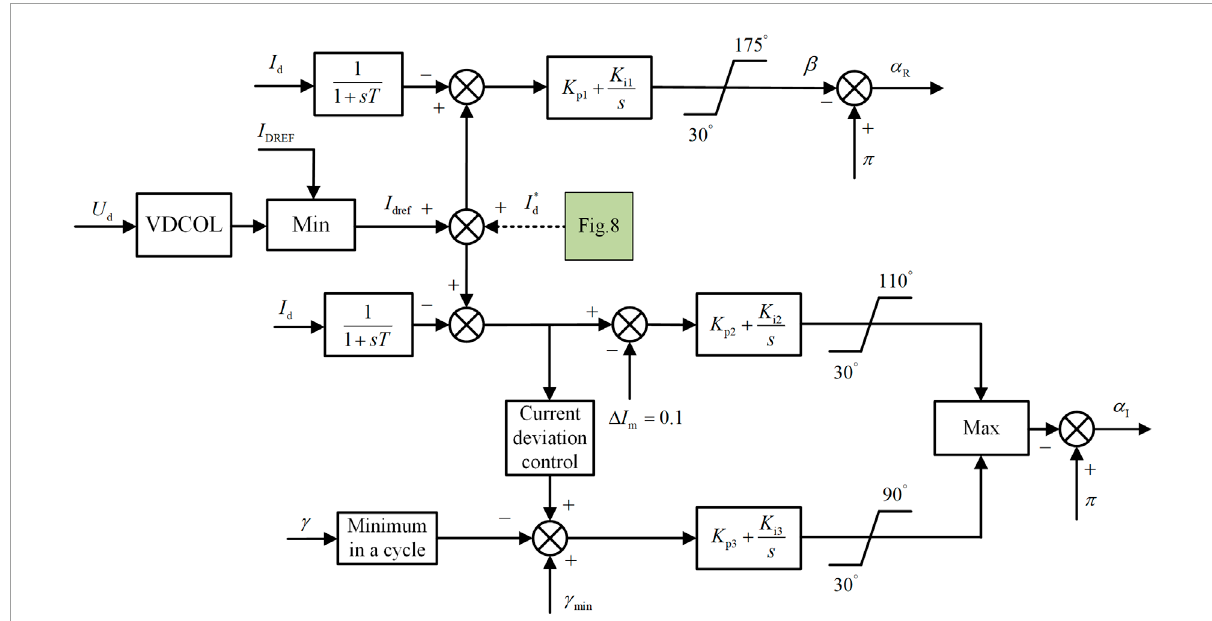
FIGURE 5 LCC-HVDC system control block diagram.